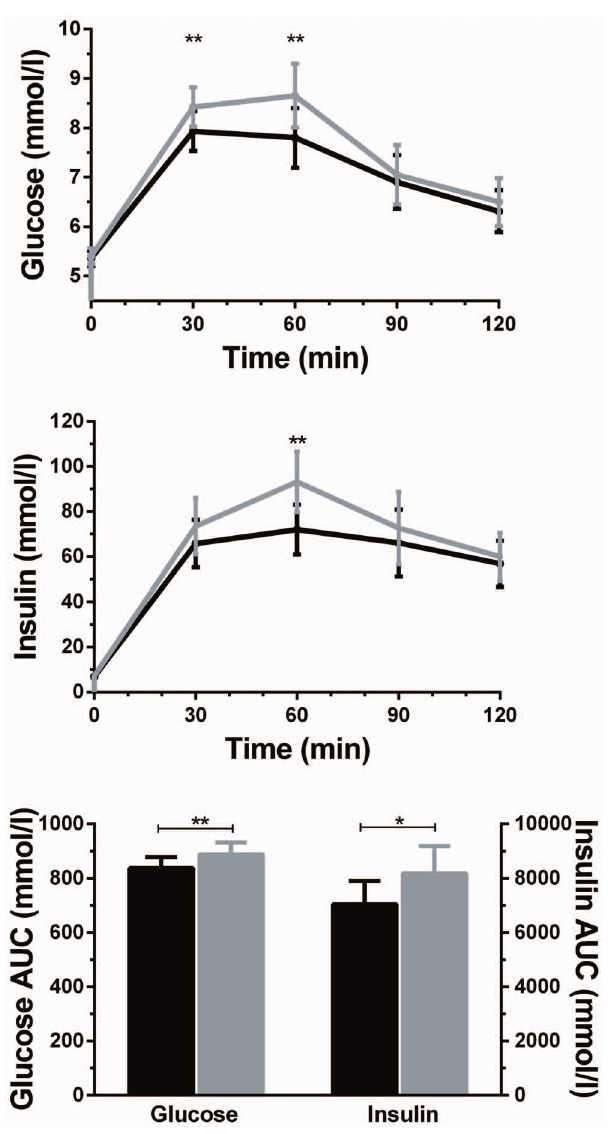
Figure 2. Insulin and glucose responses to oral glucose tolerance tests and respective areas under the curve (AUC), following supplementation with placebo (gray) and olive leaf extract (black). Data are adjusted means from multivariate models with respective 95% confidence intervals.